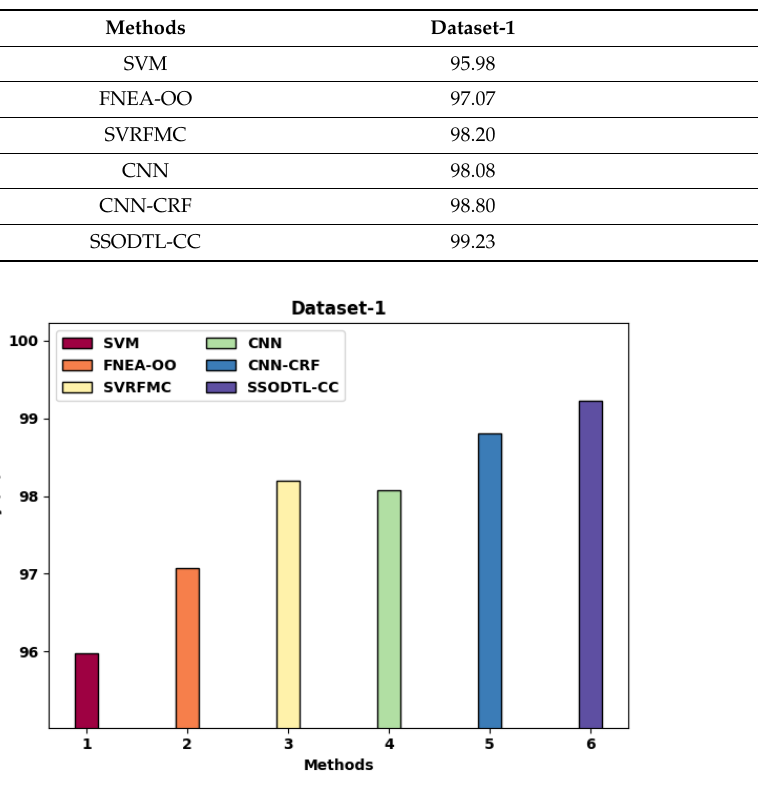
Figure 7. Comparative analysis of the SSODTL-CC technique under dataset-2.